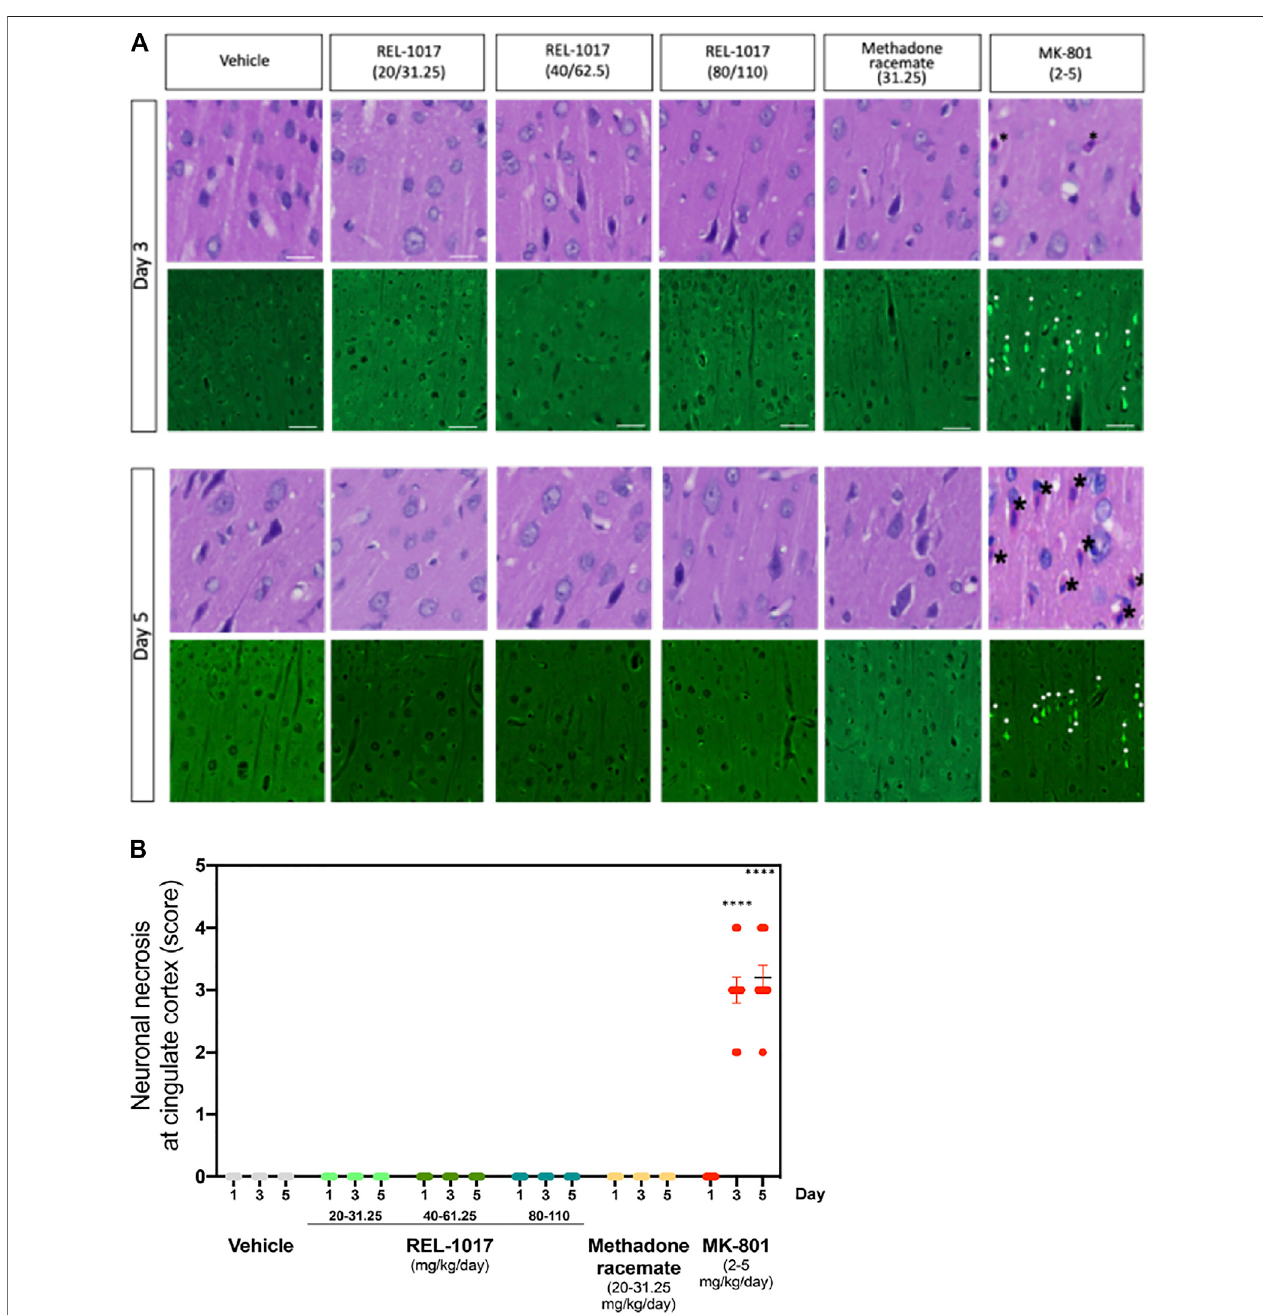
FIGURE 3 | Administration of REL-1017 did not cause neuronal necrosis in brain cingulate cortex. (A) Upper row: histological examination (H&E) of the cingulate cortex at Day 3 and 5. Black asterisk marks indicate the presence of necrotic cells, appearing as shrunken, angular cells with pyknotic nuclei and bright eosinophilic cytoplasm, in the brains of animals treated with MK-801 (positive control). Lower row: representative photographs of Fluoro Jade B immuno fl uorescence, which is a marker of cellular necrosis. Necrosis was present in the cingulate cortex and piriform lobe of MK-801 treated rats on Day 3 and 5 in 100% of the rats (M/F) (white arrowheads indicate some necrotic neuronal nuclei). Consistent with the histological analysis, Fluoro Jade B immuno fl uorescence was absent in vehicle, REL-1017, or racemicmethadonetreatedrats. (B) Quanti fi cationoftheseverityofneuronalnecrosisshowedastatisticalincreaseincellnecrosisinMK-801treatedbrains( p < 0.0001 versus all the other groups on Day 3 and 5). Necrotic fi ndings were classi fi ed as moderate to marked (ranging from 5 to 40% of necrotic cells).